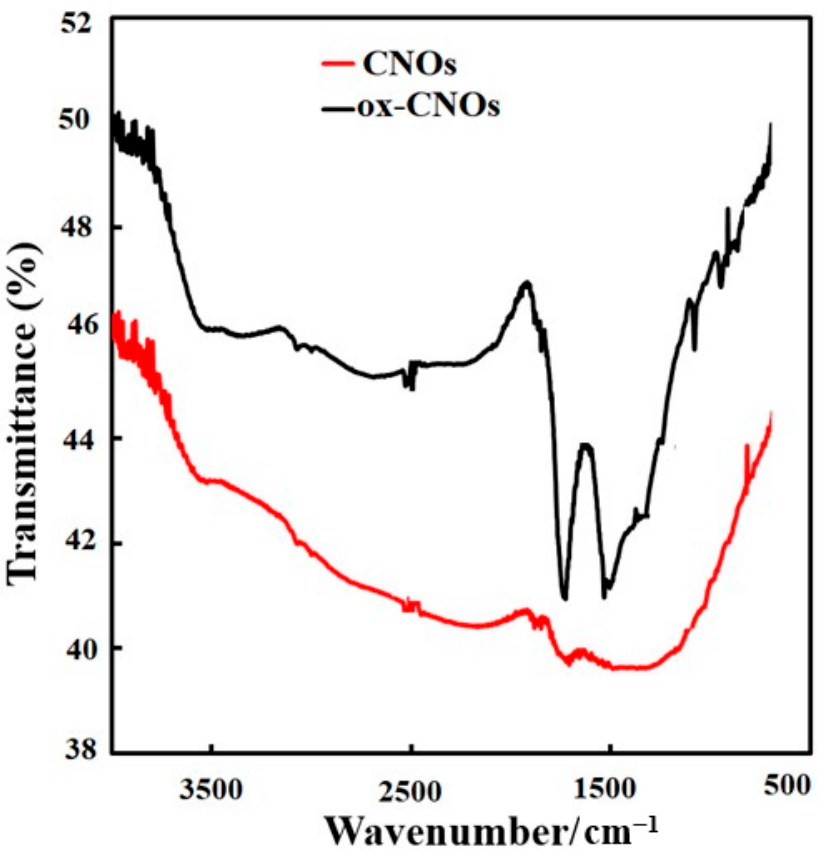
Figure 1. FT-IR spectra of CNOs and ox-CNOs. FE-SEM images for CNOs and ox-CNOs nanoparticles were given in Figure 2. For CNOs, spherical nanoparticles with a relatively uniform particle size can be observed. The ox-CNOs show smaller particles out of the spherical state accumulated in a needle-shaped state. Figure 3 depicts the XRD patterns of CNOs and ox-CNOs. Broad peaks at 2 θ = 24.3 and 44 are visible for CNOs. After oxidation of CNOs, the broadening of mentioned peaks occurred and a significant reduction in their intensity was observed.